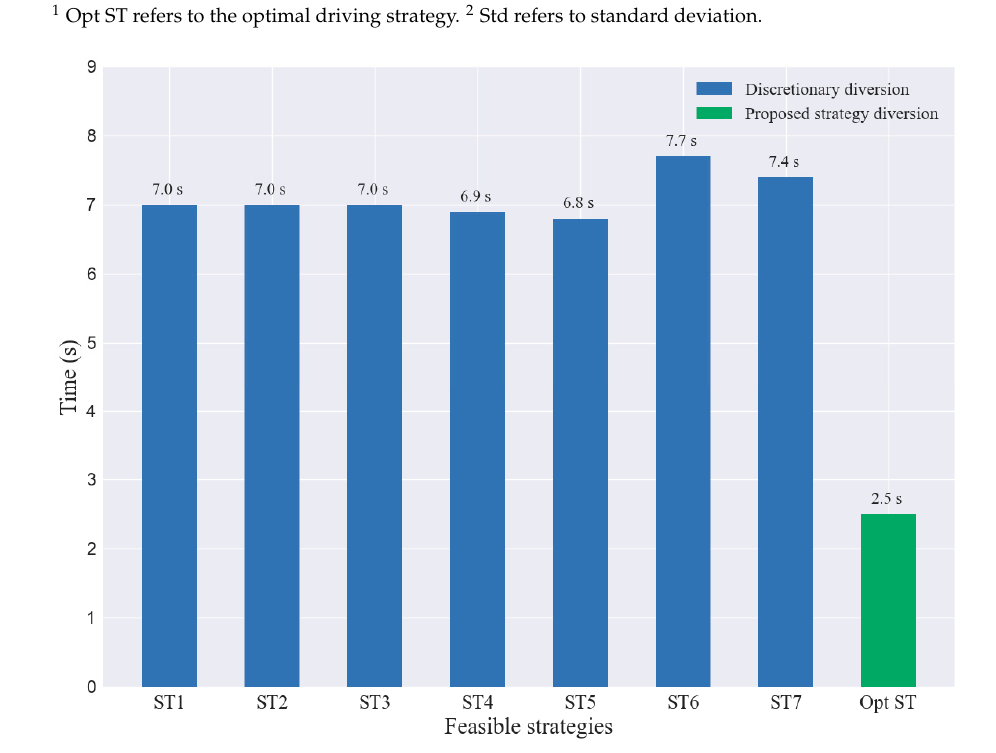
Table 3. Desired velocity and travel time for each vehicle travel through DIA.